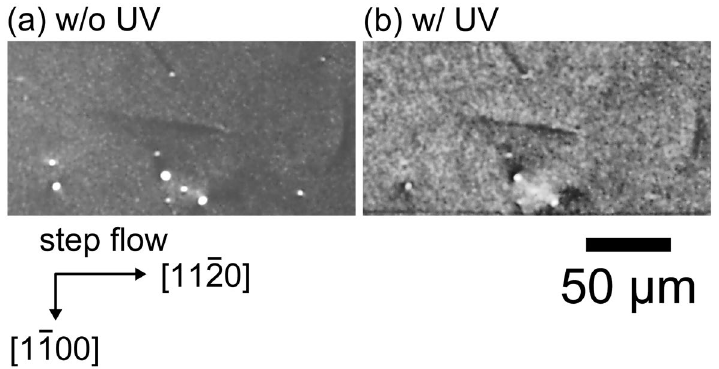
Figure 6. X-ray topography images of epitaxial layer with thickness of 5 µm, nitrogen concentration of 6 × 10 15 cm −3 , and 0.3-MeV proton irradiation at a fluence of 1 × 10 15 cm −2 after annealing at 1973 K for 1 h. X-ray topography images were taken ( a ) before and ( b ) after UV illumination on the specimen with power of 10 W cm −2 at 373 K for 10